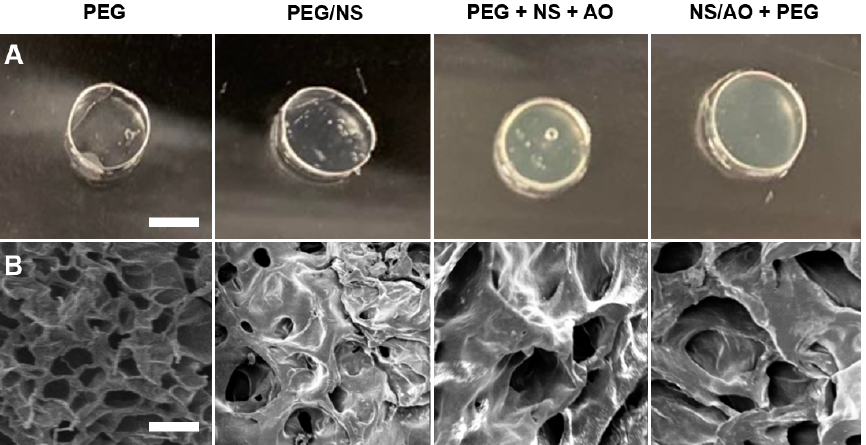
Figure 5. Hydrogel Morphology Characterization. Optical ( A ) and SEM ( B ) images of PEG, PEG/NS, PEG + NS + AO, and NS/AO + PEG hydrogels. Scale bars represents 10 mm ( A ) and 50 μ m ( B ).